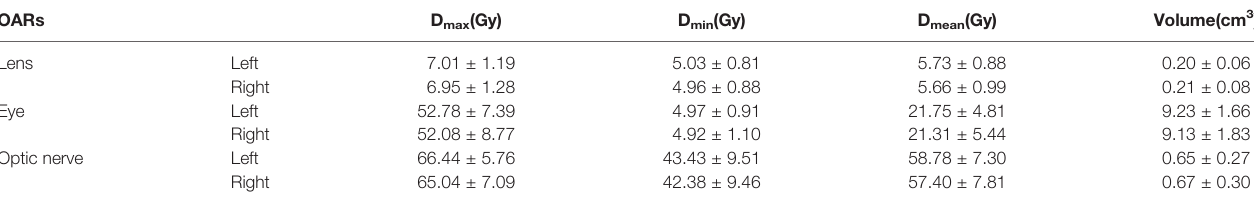
TABLE 3 | Dose-volume parameters of organs at risk (OARs) (mean ± SD). OARs D max (Gy) D min